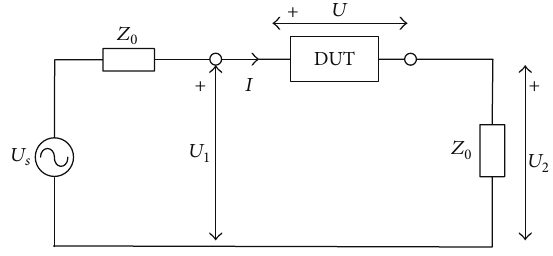
Figure 5: Measurement circuit reference